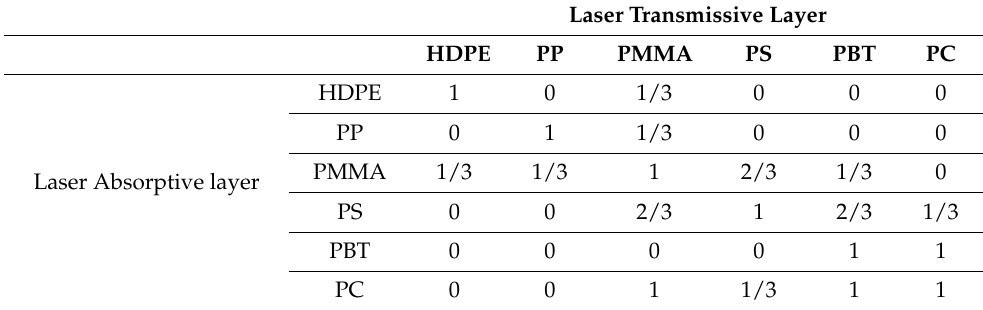
Table 4. Weldability matrix from LPKF Laser and Electronics AG 1 = good welded joint, 2/3 = satisfac- tory welded joint, 1/3 = poor welded joint and 0 = no welded joint [192]. High-density polyethylene (HDPE), PP, poly(methyl methacrylate) (PMMA), polystyrene (PS), polybutylene terephthalate (PBT) and polycarbonate (PC). Laser Transmissive Layer HDPE PP PMMA PS